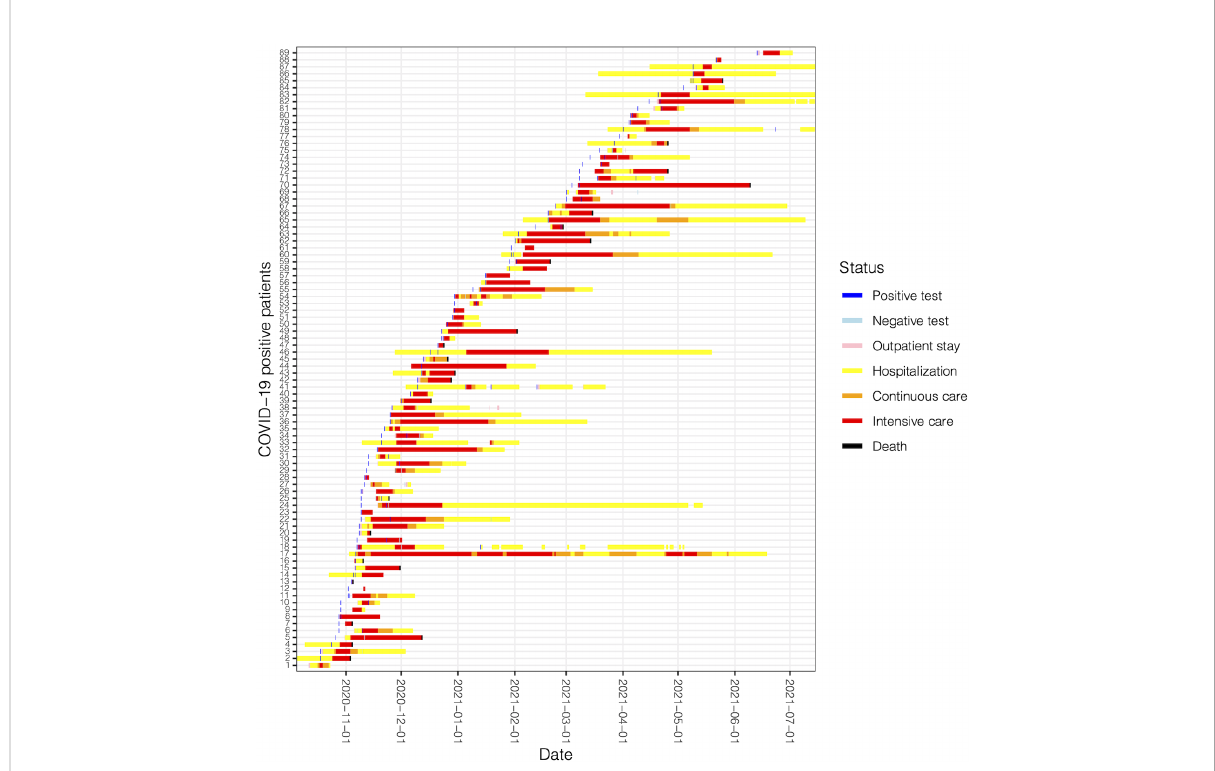
FIGURE 4 Timeline of patient journeys for active patients of the second wave going through ICU. Each line represents a patient with a coded ID number.